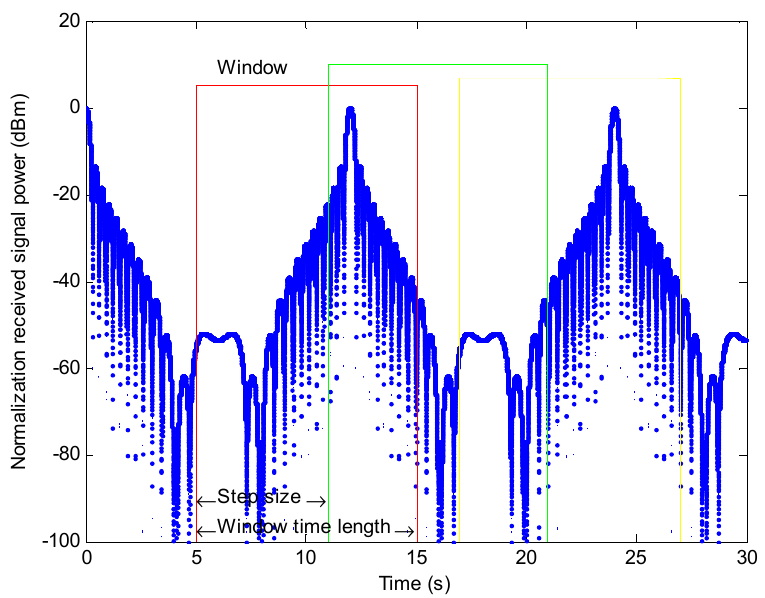
Figure 7. Illustration of the window time length and step size of the data used to create the CNN input image data.